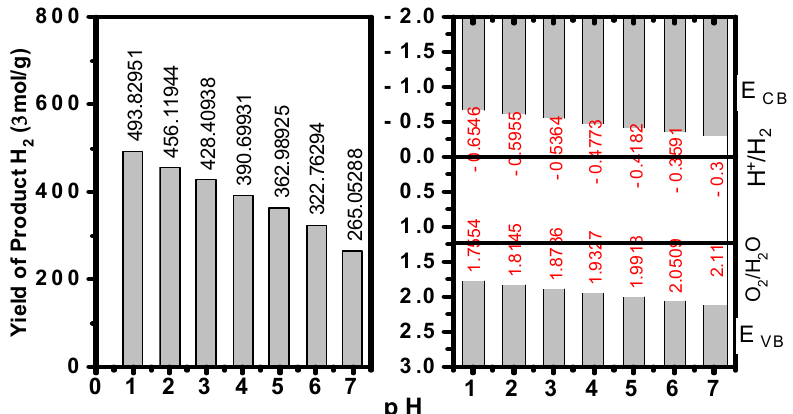
Figure 5. Photocatalytic performance of ZnO/MAPbI 3 /Fe 2 O 3 in H 2 evolution from H 2 O splitting. Photocatalytic H 2 production rate with different pH (1–7) left, and energy levels of conduction band and valence band with different pH (1–7) right.